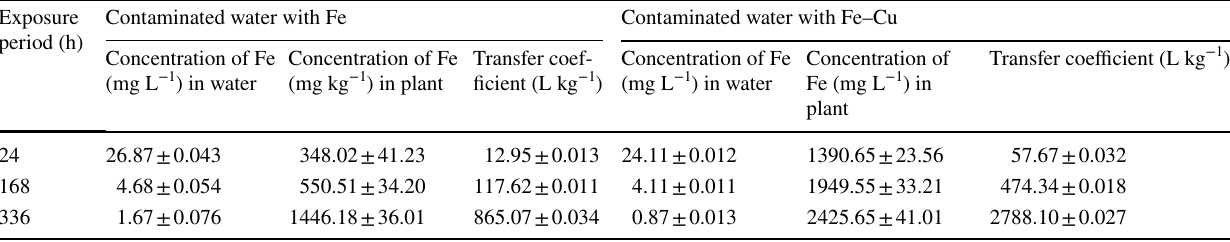
Table 2 Variation of Fe concentration in water and in plant and water–plant transfer coefficient as a function of exposure period (mean ± stand- ard